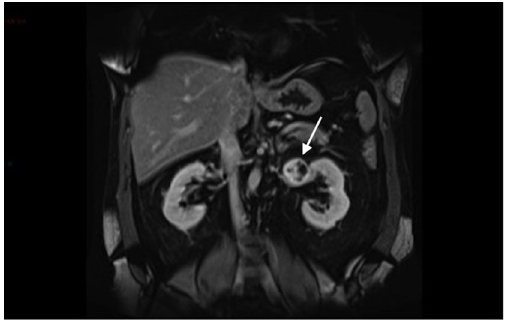
Figure 5 - Coronal T1 late post-contrast phase shows progressive enhancement of the